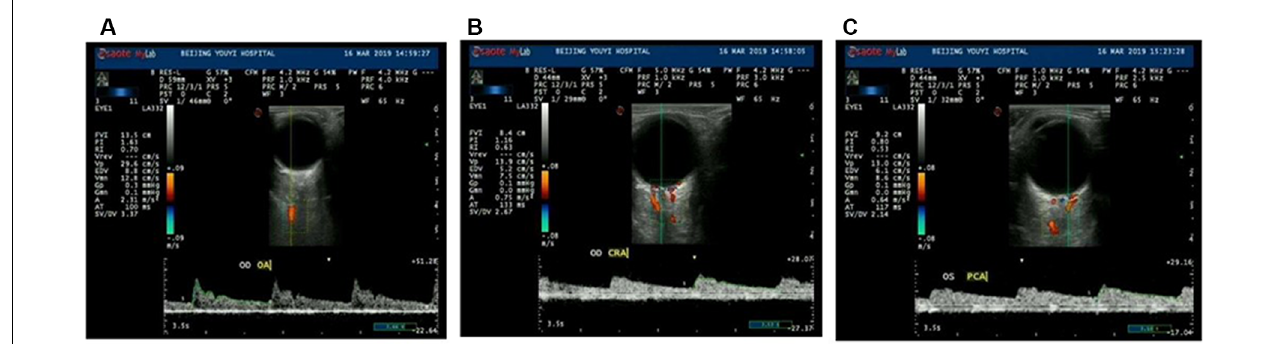
FIGURE 1 | Ultrasound Doppler examinations of ocular vessels and the measurement process of major vascular parameters. The parameters are as follows: peak systolic velocity (PSV is shown as Vp), end-diastolic velocity (EDV), resistance indices (RI), and pulsatility index (PI). The images demonstrate measurements of the ophthalmic artery (OA; A ), central retinal artery (CRA; B ), and posterior ciliary artery (PCA; C ).